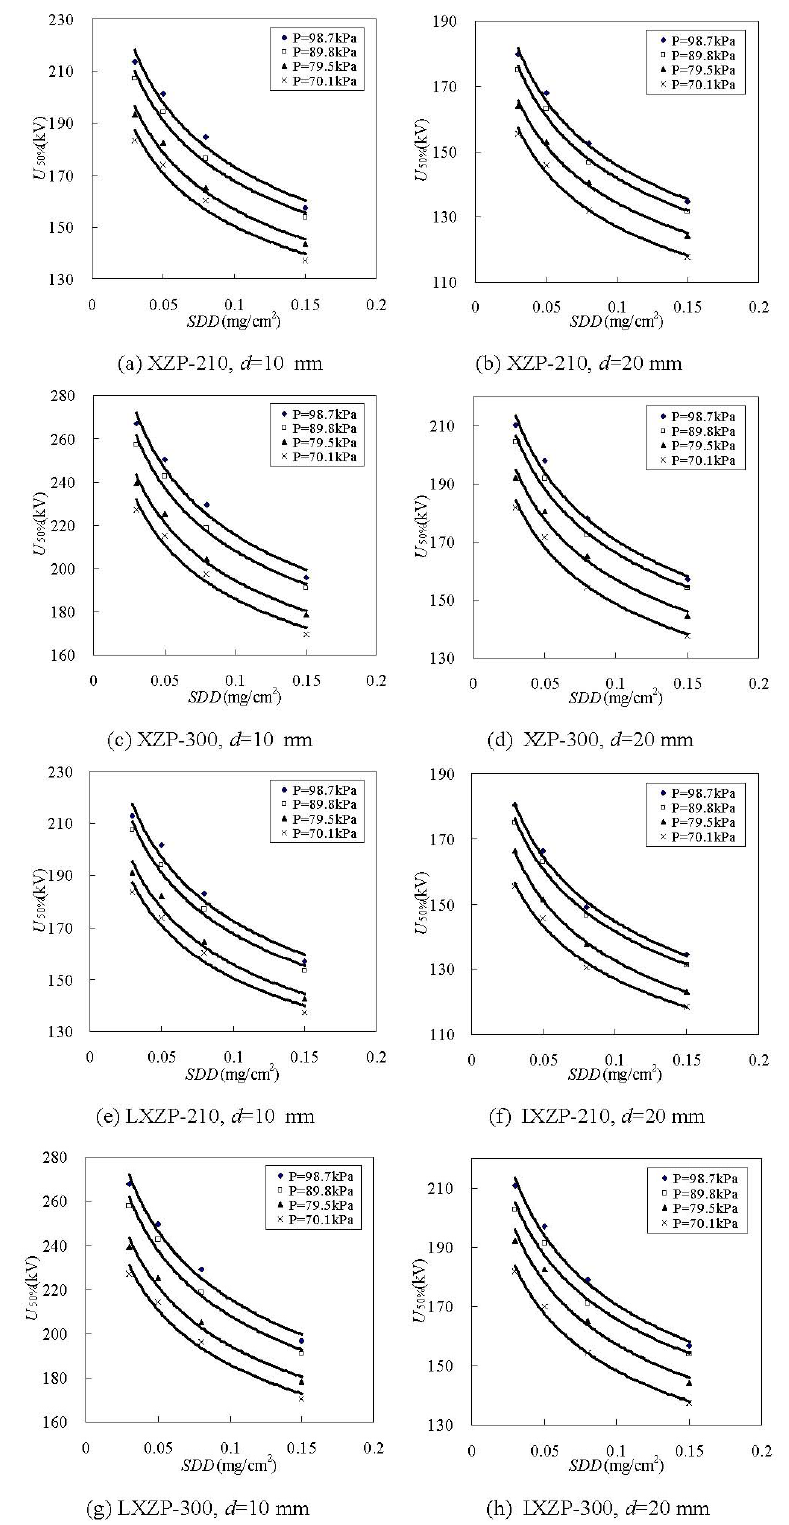
and SDD of insulator strings covered with 50%